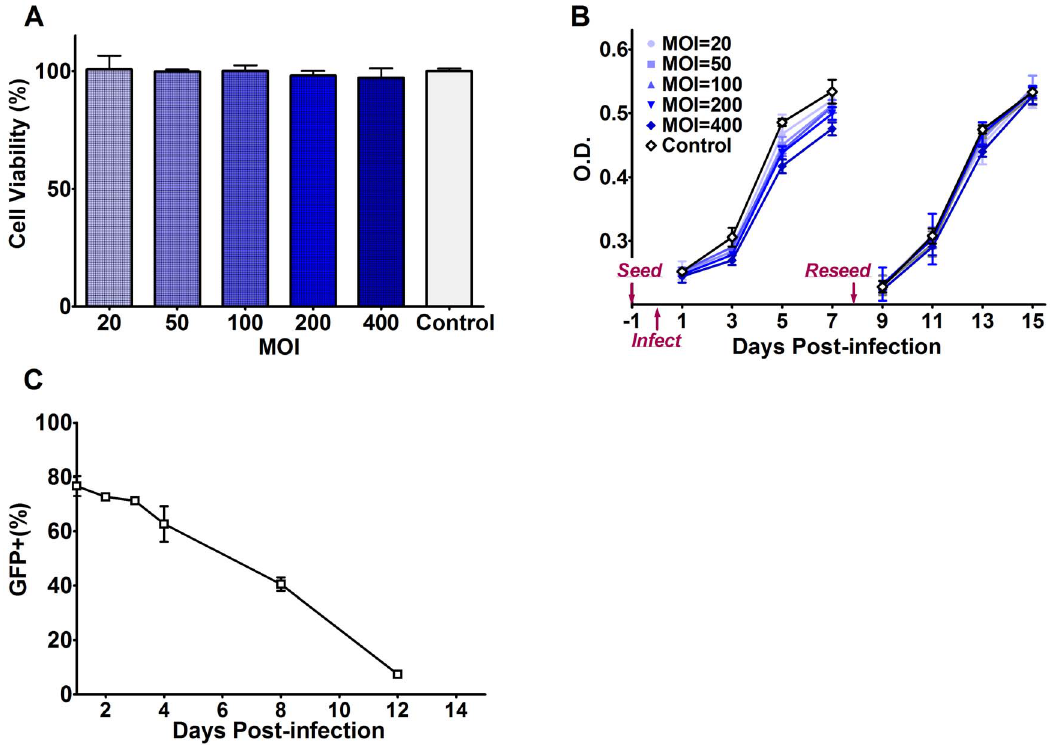
Figure 3. Effects and duration of transgene expression in baculovirus-infected hUCB-MSCs. A : Cell viability of hUCB-MSCs infected with Bac-NIS at different MOIs at 24 hpi as detected by the CCK-8 assay. B : Cell proliferation of hUCB-MSCs infected by Bac-NIS at different MOIs over time (1, 3, 5, 7, 9, 11, 13 and 15 dpi), as detected by the CCK-8 assay. The cells were seeded 1 day before infection with Bac-NIS and reseeded at 8 dpi when the cells reached , 80% confluency. C : GFP + % of Bac-GFP-infected hUCB-MSCs over time (1, 2, 3, 4, 8 and 12 dpi). The cells were reseeded at 8 dpi when reached , 80% confluency. Results are means 6 SD (n=3). Abbreviations : Bac-NIS, recombinant baculovirus carrying sodium-iodide symporter reporter gene; dpi, days post-infection; CCK-8, Cell Counting